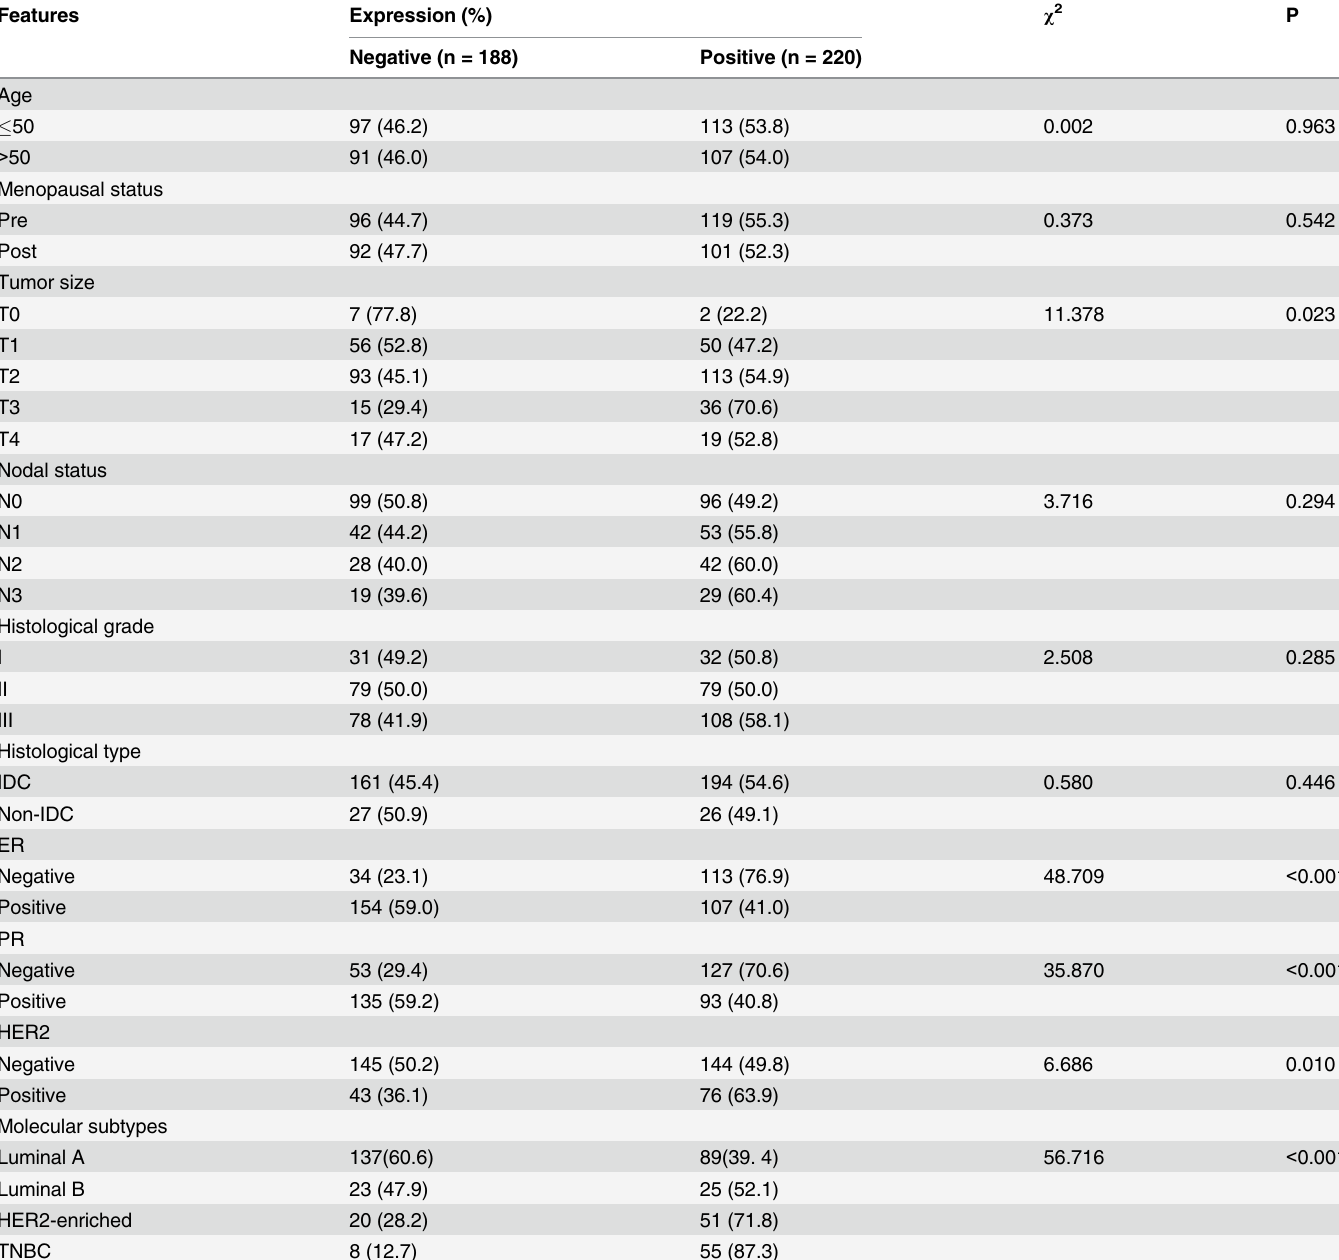
Table 2. Relationship of Twist expression and clinicopathological features in breast cancer